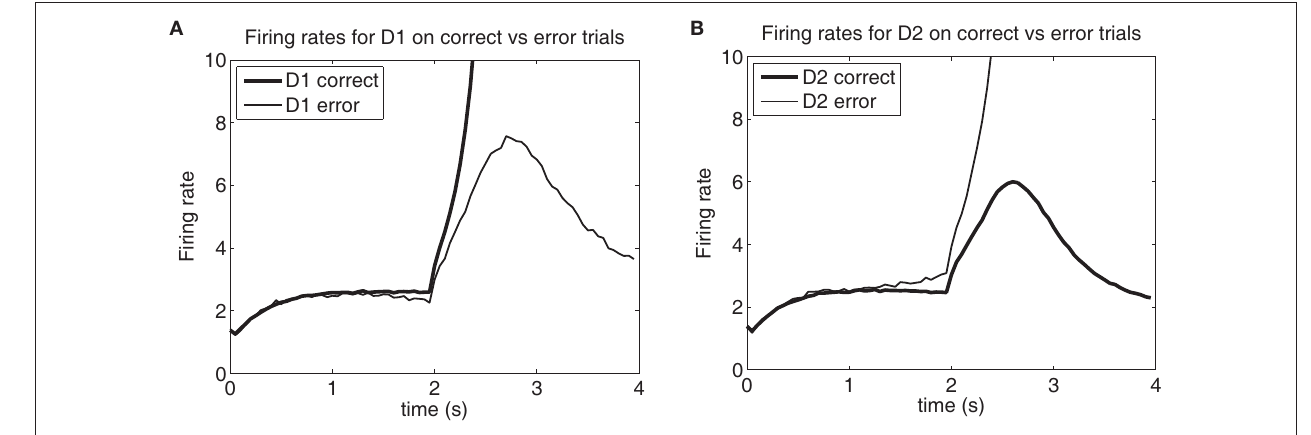
population lost. (B) When the D2 population on error trials due to the noise won there was markedly more firing before the decision cues were applied (extending back as much as 1000 ms) than when on correct trials the D2 population lost (see text). The firing rates are averaged over 898 trials, on 88% of which the D1 population correctly won.